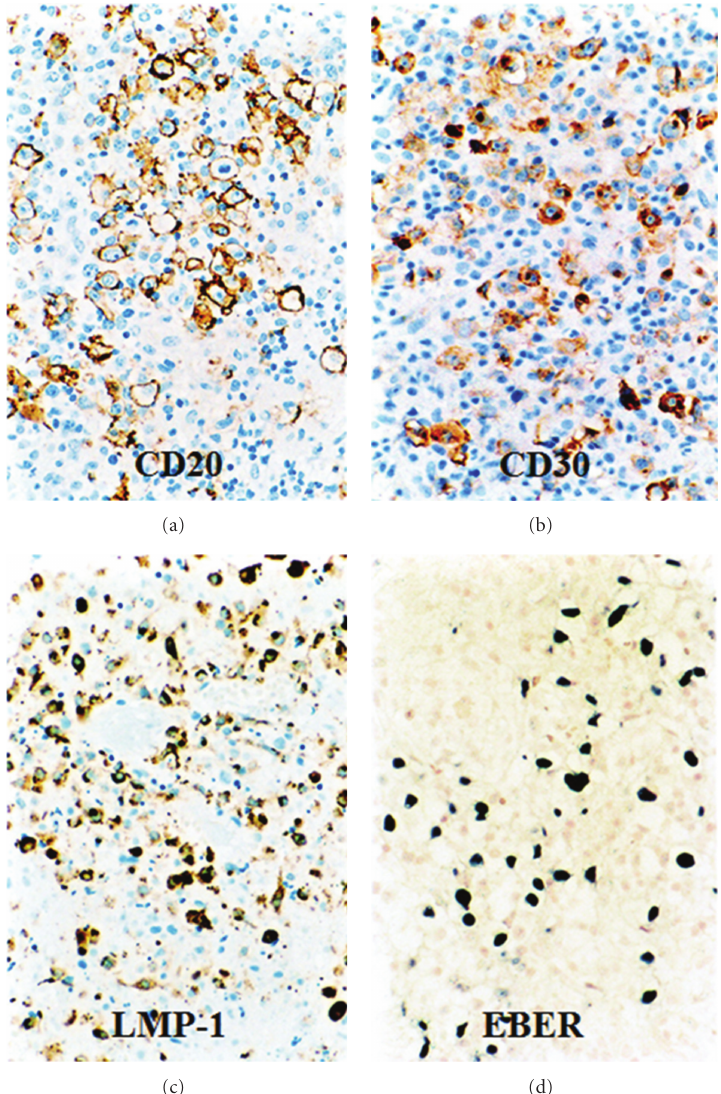
Figure 3: Immunohistochemical stainings for CD20, CD30 and LMP-1 and EBER staining (in situ hybridization). Tumor cells are positive for CD20, CD30, LMP-1 and EBER, original magnification × 300.